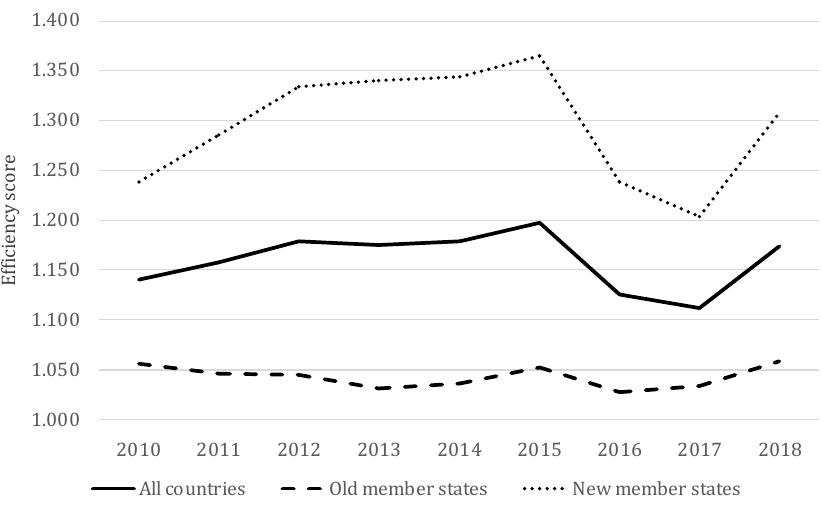
Figure 2. Time evolution of the average efficiency scores for the country groups.